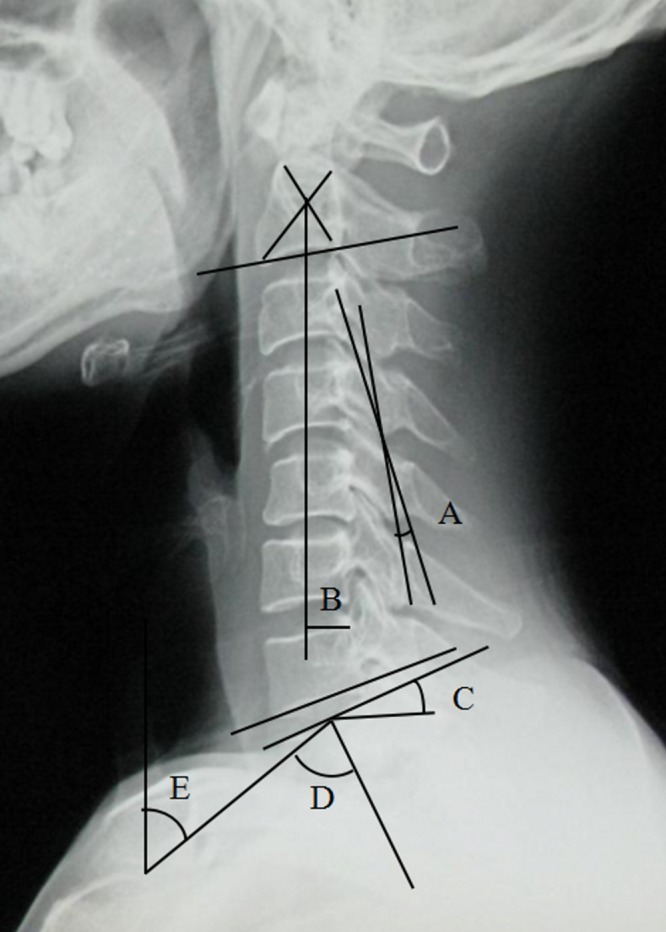
Preoperative radiographic measurement.(A) CL, (B) C2–7 SVA, (C) T1S, (D) TIA, (E) NT.